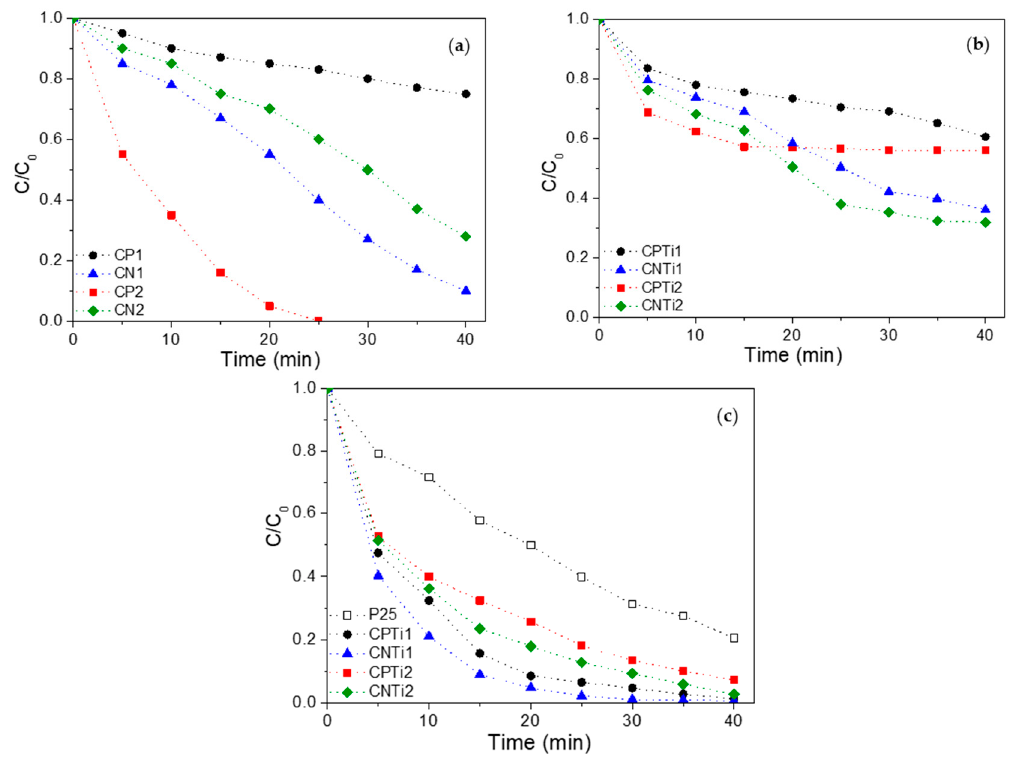
Figure 8. Removal of Orange G (OG) from water solution by ( a ) adsorption using pure carbon materials and ( b ) adsorption and ( c ) photocatalysis using carbon–Ti composites.